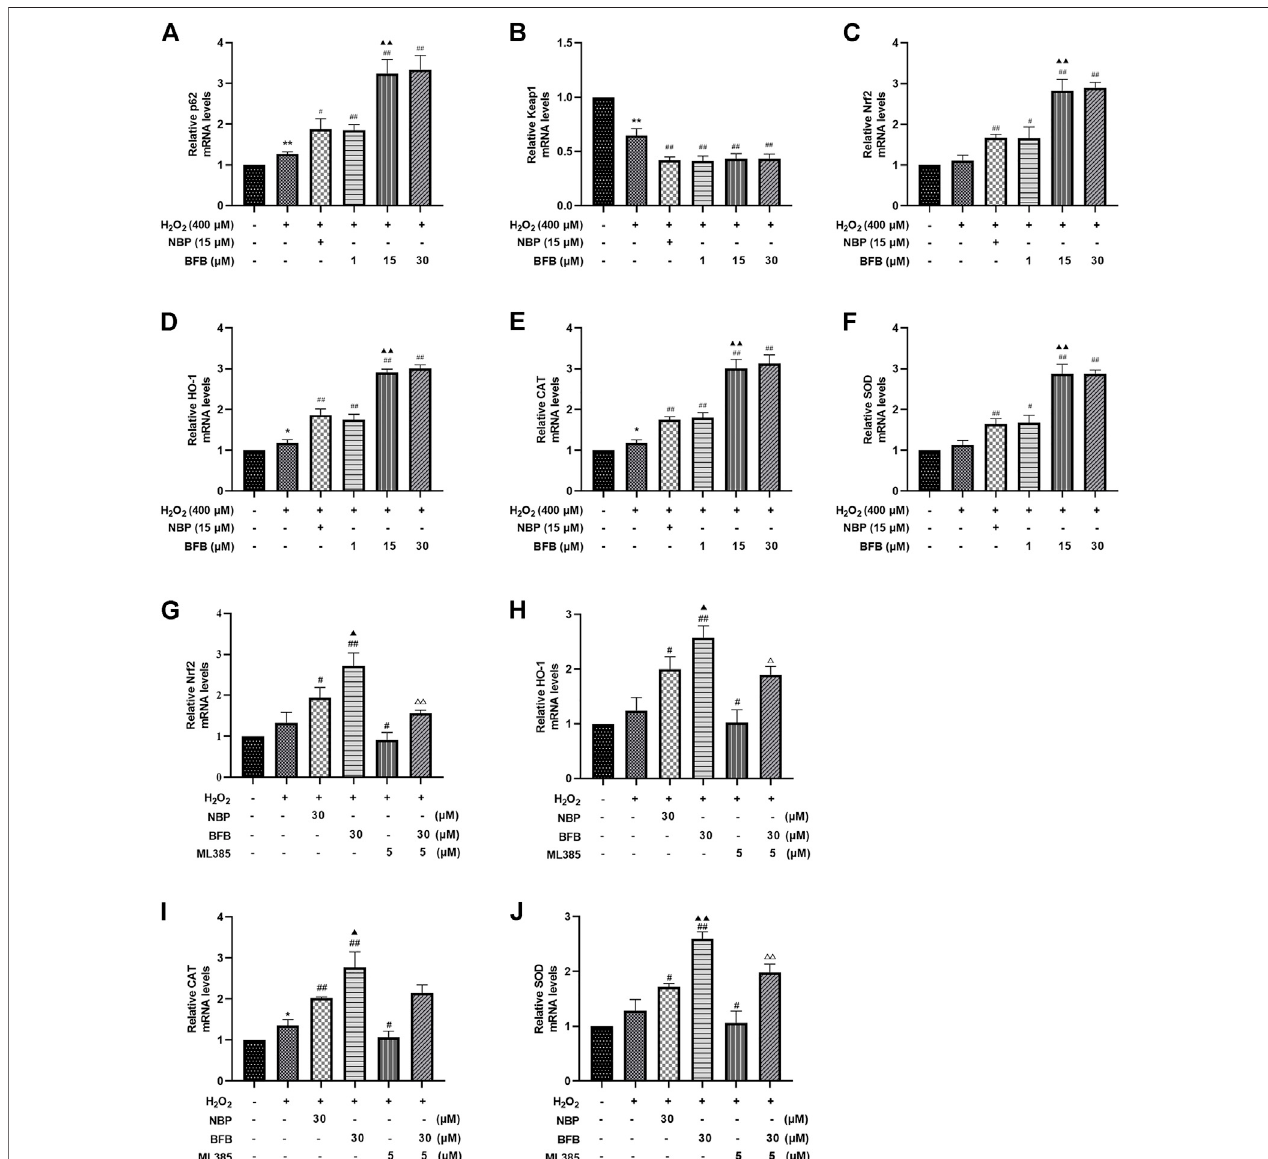
FIGURE 4 | BFB ’ s role in cellular P62-Keap1-Nrf2 pathway-related factors expression level. H 2 O 2 (400 μ m) was added to treat PC12 cells with/without BFB (1, 5, 10 μ m)orNBP(15 μ m)fora3-hperiod.RT-qPCRwasconductedtoanalyzemRNAexpression (A) p62 (B) keap1 (C) Nrf2 (D) HO-1 (E) CAT (F) SOD.Nrf2suppression alleviatedBFB ’ sinhibitionagainstoxidativestress.5 μ mML385wasaddedtopretreatPC12cellsfora0.5-hperiod,followedbyH 2 O 2 (400 μ m)stimulationwith/without BFB(30 μ m)orNBP(30 μ m) (G) Nrf2 (H) HO-1 (I) CAT (J) SOD.Datawererepresentedbymean±SDfrom3separateassays.* p < 0.05,** p < 0.01,versusControl, ▲ p < 0.05, ▲▲ p < 0.01, versus NBP group. △ p < 0.05, △△ p < 0.01, versus ML385 # p < 0.05, ## p < 0.01, versus H 2 O 2 group.